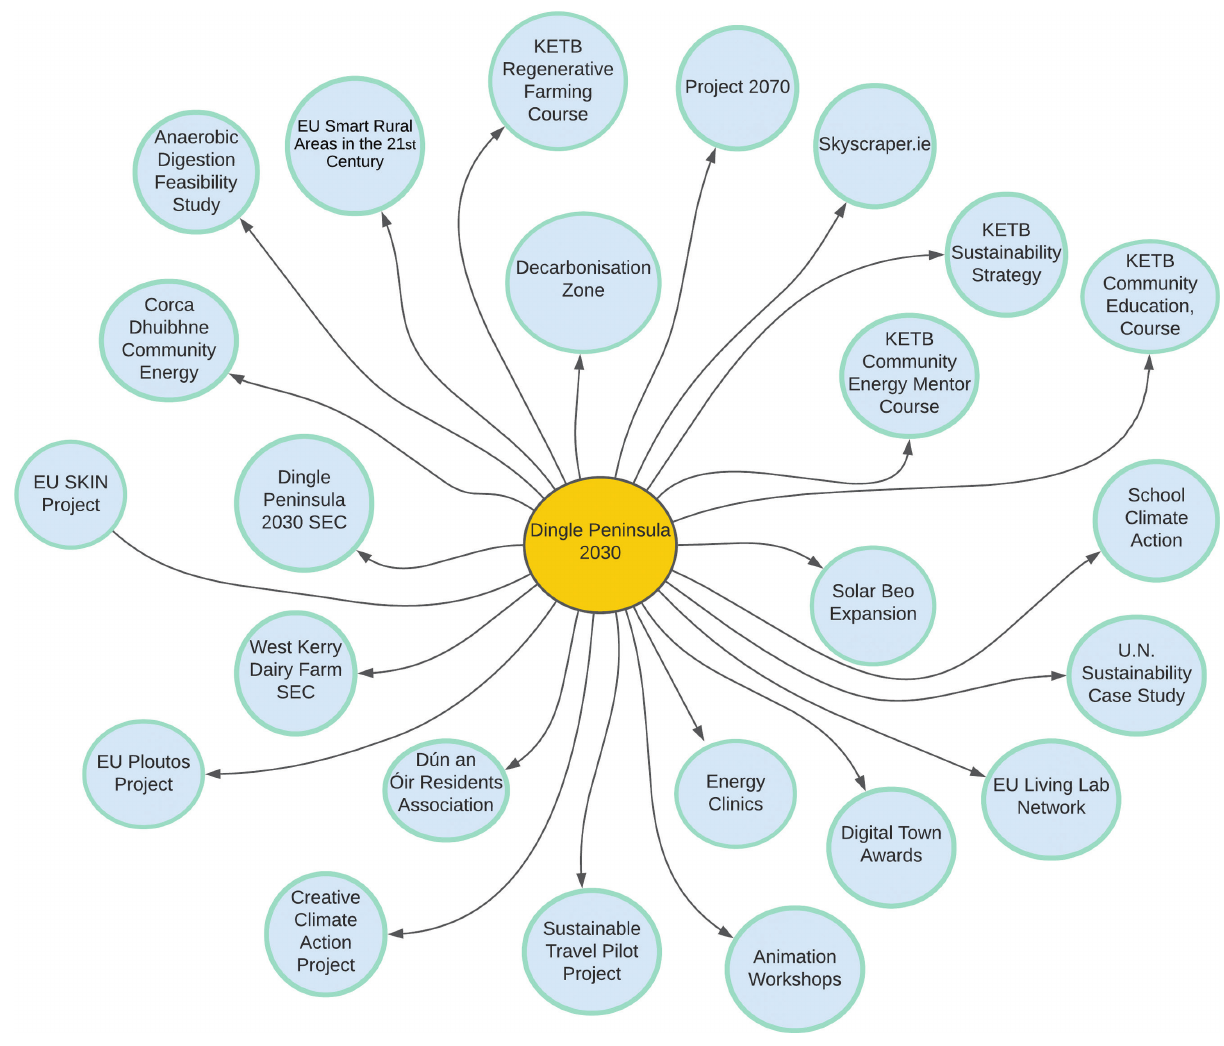
Visual representation of the diffusion of sustainability as part of Dingle Peninsula 2030